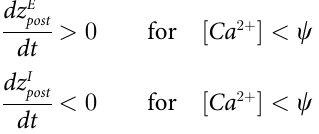
While we were unable to find experimental evidence on the activity of excitatory or inhibi- tory neurons just outside the LPZ, in our simulations, these neurons exhibit increased activity after deafferentation ( t = 2000 s in Fig 3C). Unlike neurons in the LPZ that suffer a net loss of excitation, these neurons appear to suffer a net loss of inhibition, which indicates that they